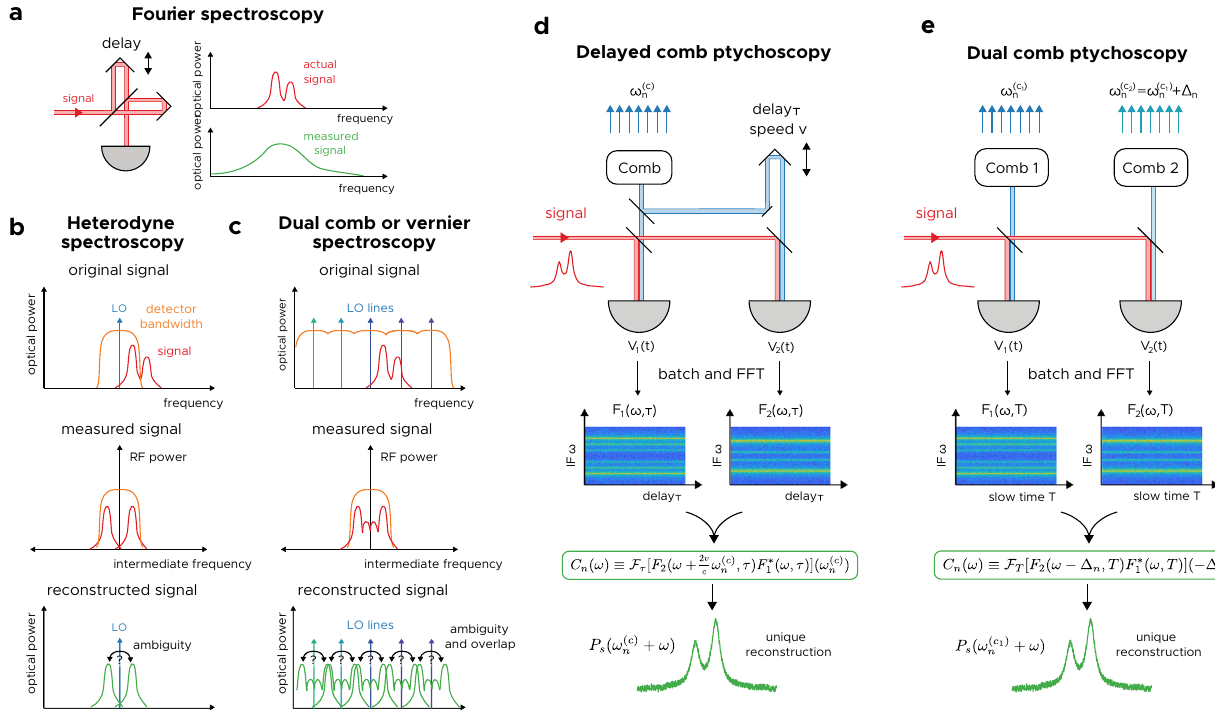
Fig. 2 Comparison of various spectroscopic methods with frequency comb ptychoscopy. Various existing spectroscopic approaches ( a – c ) and ptychoscopic approaches ( d , e ). a In Fourier spectroscopy, high-resolution information is lost. b In heterodyne spectroscopy, information beyond the detector bandwidth is lost. c In vernier spectroscopy, high resolutions can be obtained using a comb, but overlapping signals result in highly ambiguous (non-invertible) spectral reconstructions. d In delayed comb ptychoscopy, one comb is split and delayed; both copies are beat with the signal to uniquely reconstruct it. e In dual comb ptychoscopy, two combs are independently beat with the signal. Both detectors ’ spectrograms are computed and are correlated to reproduce the original signal ’ s spectrum to high resolution (the inverse of the measurement time divided by the number of comb